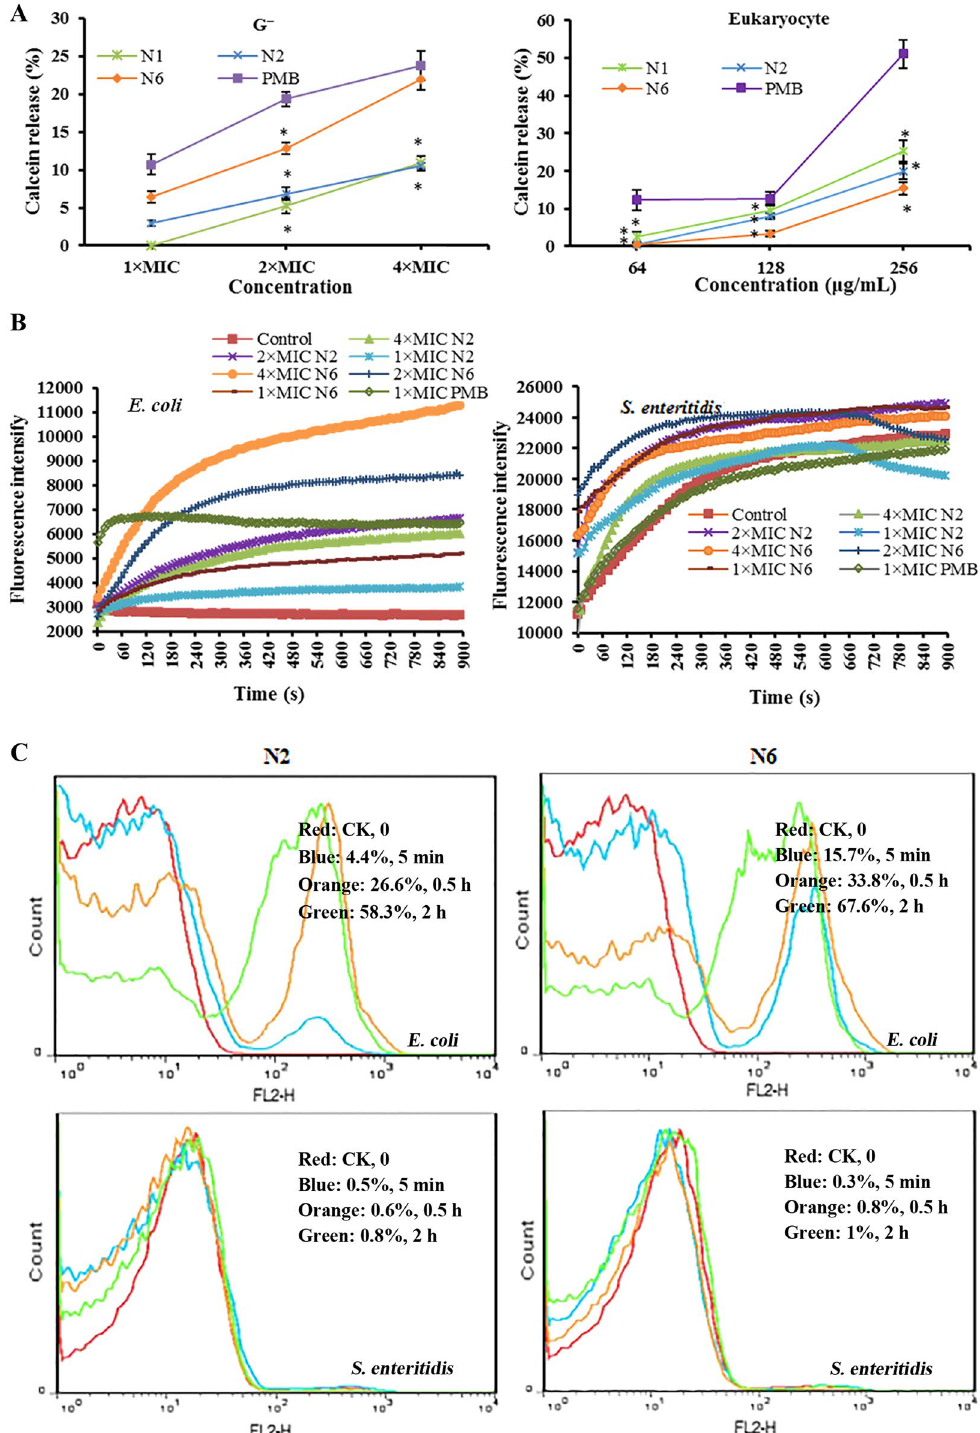
Figure 3. Penetration of biofilms by N2 and N6. ( A ) Calcein leakage from POPC/POPG = 4:1 (gram-negative) and POPC/cholesterol = 1:1 (eukaryotic) model membranes induced by different concentrations of N2 and N6, respectively. The results are given as the mean ± SEM (n = 3). Differences between groups were determined by one-way ANOVA followed by SPSS analysis. * p < 0.05 compared to the PMB group. ( B ) Outer membrane permeabilization assays of N2 and N6. ( C ) Flow cytometric analysis of PI-staining in E . coli CVCC195 and S . enteritidis CVCC3377 cells treated with 1 × MIC N2 and N6, respectively. Red line: no peptide, negative control; Blue line: treatment with peptides for 5 min; Orange line: treatment with peptides for 0.5 h; Green line: treatment with peptides for 2